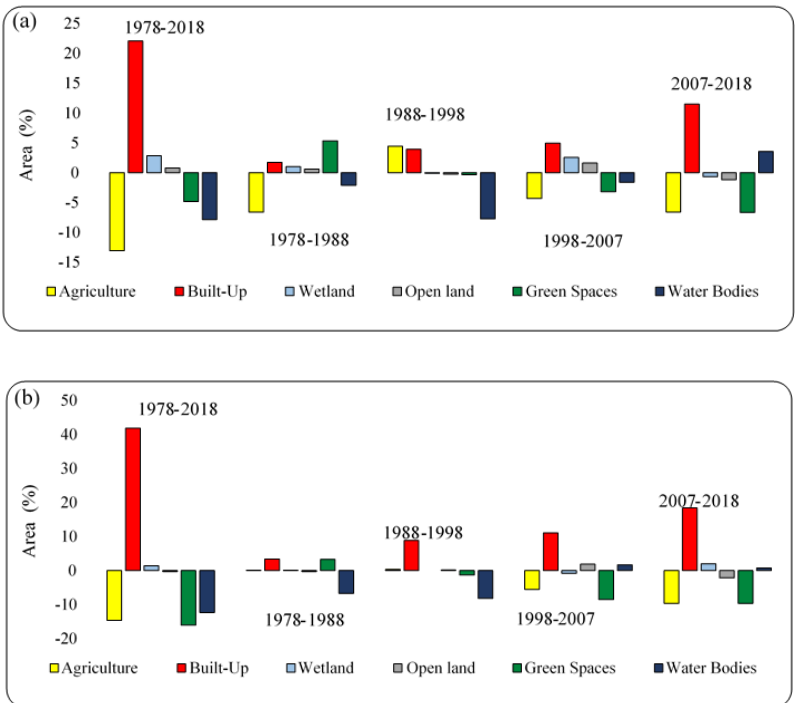
Figure 7. Relative LULC changes; ( a ) for entire catchment area; ( b ) for Dhaka city area during 1978– 2018.